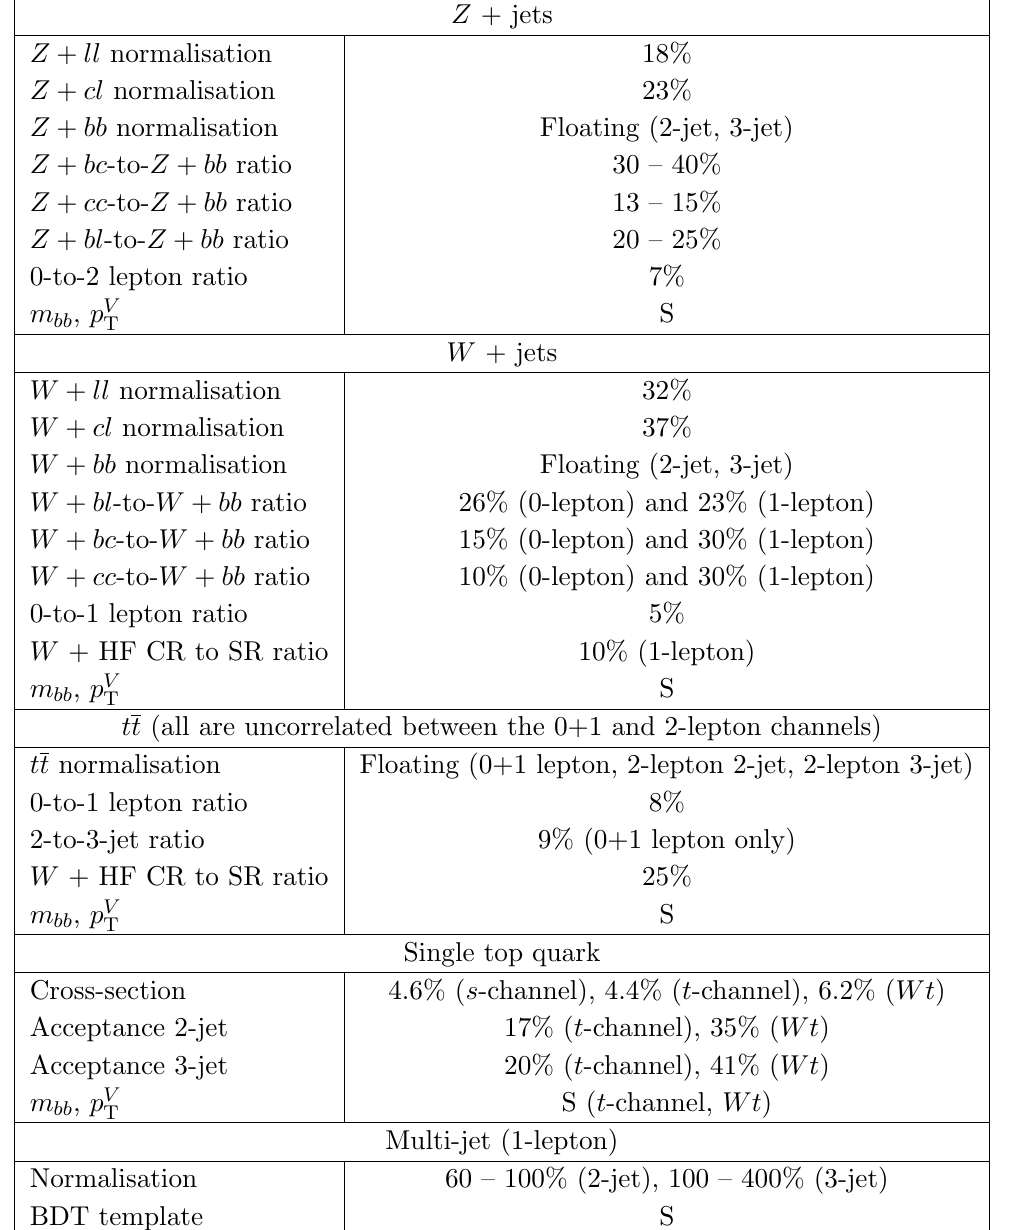
Table 6 . Summary of the systematic uncertainties in the background modelling for Z + jets, W + jets, tt , single top quark and multi-jet production. An \S" symbol is used when only a shape uncertainty is assessed. The regions for which the normalisations (cid:13)oat independently are listed in